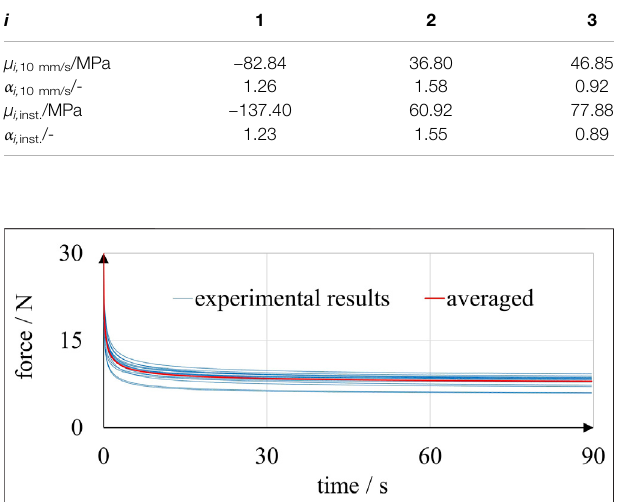
FIGURE 7 | Results of relaxation experiments with linear A30 bellows actuators including data from Dämmer et al. (Dämmer et al., 2019a). Each bellowsactuator wasloadedtwice, and eight differentbellowsactuators were used in total (blue lines). The averaged results (red line) were used to calibrate a four-term Prony